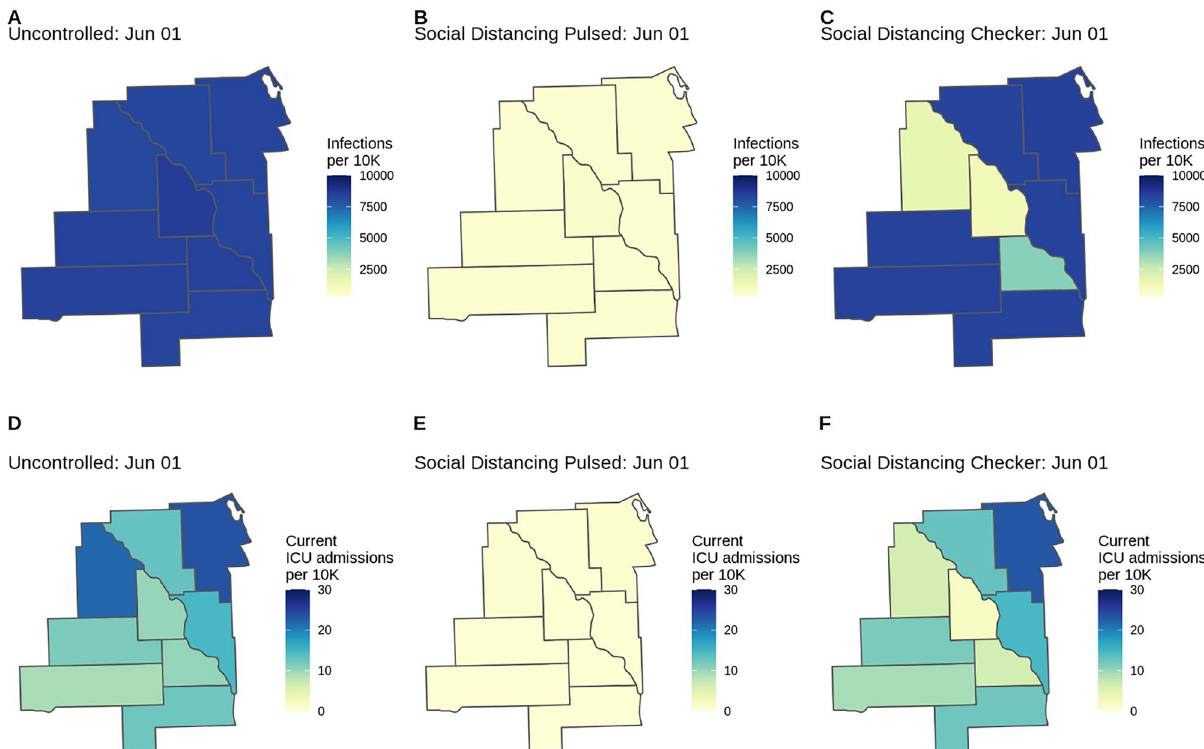
Figure 4. County-level COVID-19 risk for three scenarios (Uncontrolled, Pulsed, Checker) in the fictional Location X. Choropleths for model outcomes on June 1, 2020 of the ( A – C ) cumulative infection rate per 10,000 population and ( D – F ) number of patients currently admitted to the ICU per 10,000 population for the Uncontrolled, Social Distancing Pulsed, and Social Distancing Checker intervention scenarios. County- level variation in attack rates can arise from differences in risk of importation, mobility patterns connecting subdivisions, and differences in non-pharmaceutical interventions applied in each location. If location-specific health outcome risks are specified (as are age-standardized health outcome risks in this example), this may serve as another source of county-level